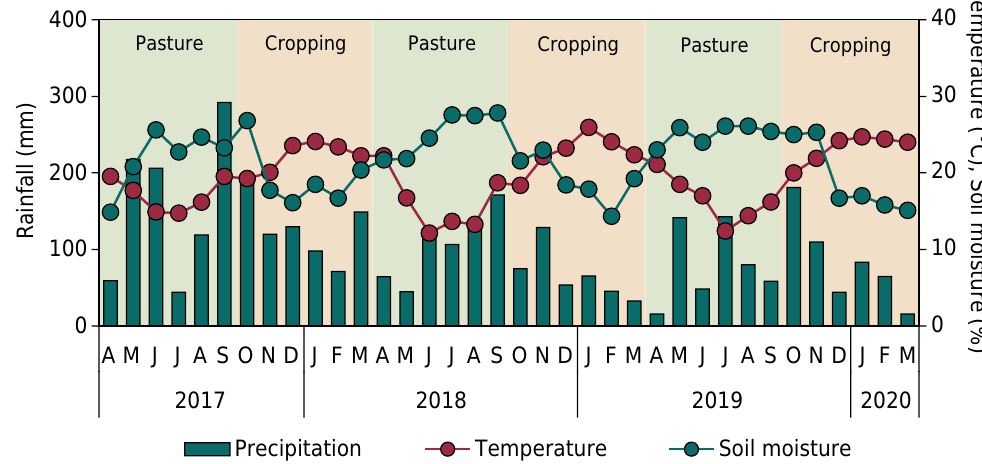
Figure 1. Rainfall, mean air temperature and soil moisture over the three pasture (2017, 2018, and 2019) and cropping cycles (2017/2018, 2018/2019, and 2019/2020) in the ICLS evaluated in Southern